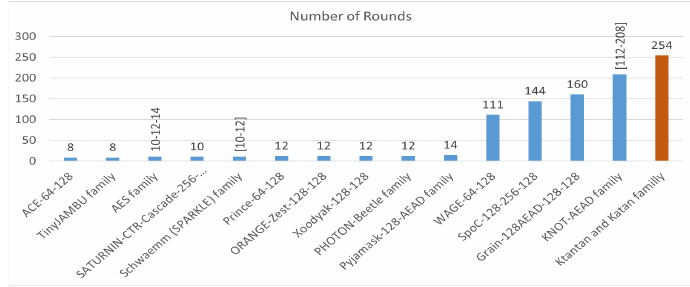
Figure 2. 19 algorithms of smallest N of rounds and 13 of the